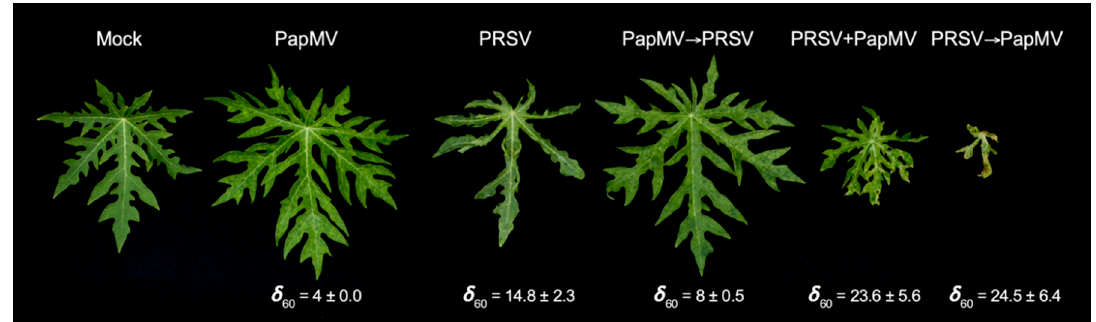
Figure 1. Leaves of mock-inoculated and virus-infected plants showing symptoms at 60 days post infection (dpi) with damage values ( δ 60 ). Single infections of PapMV (Papaya mosaic virus), PRSV (Papaya ringspot virus), stepwise infection of PapMV → PRSV resulting in antagonism, stepwise infection of PRSV → PapMV, and co-inoculation of PRSV with PapMV, resulting in synergism.